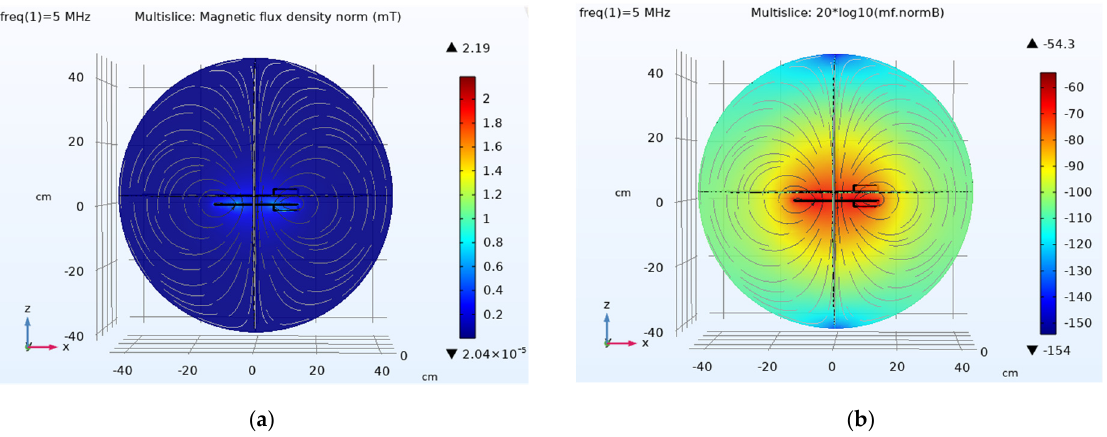
Figure 6. Simulation results at f 0 = 5 MHz with d =4 cm; ( a ) magnetic field distribution; ( b ) magnetic field in dB.